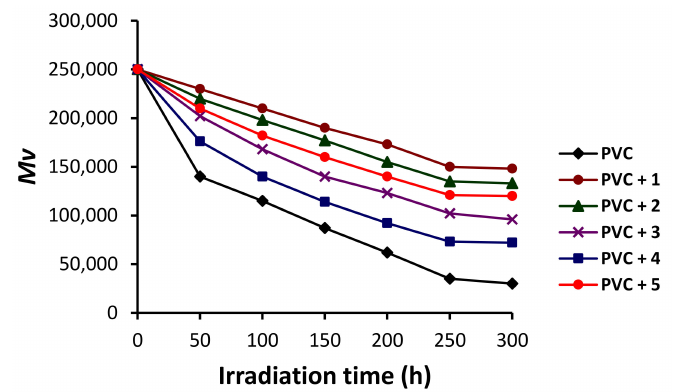
Figure 7. Changes in the M V of PVC upon irradiation.